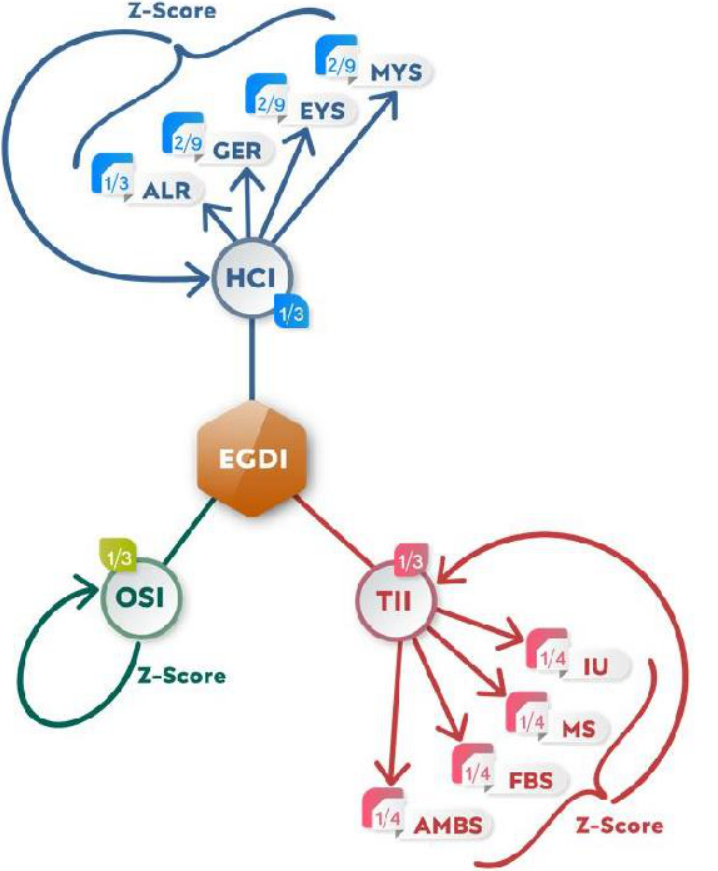
Figure 1. E-Government Development Index (EGDI) structure is based on the United Nations meth- odology.